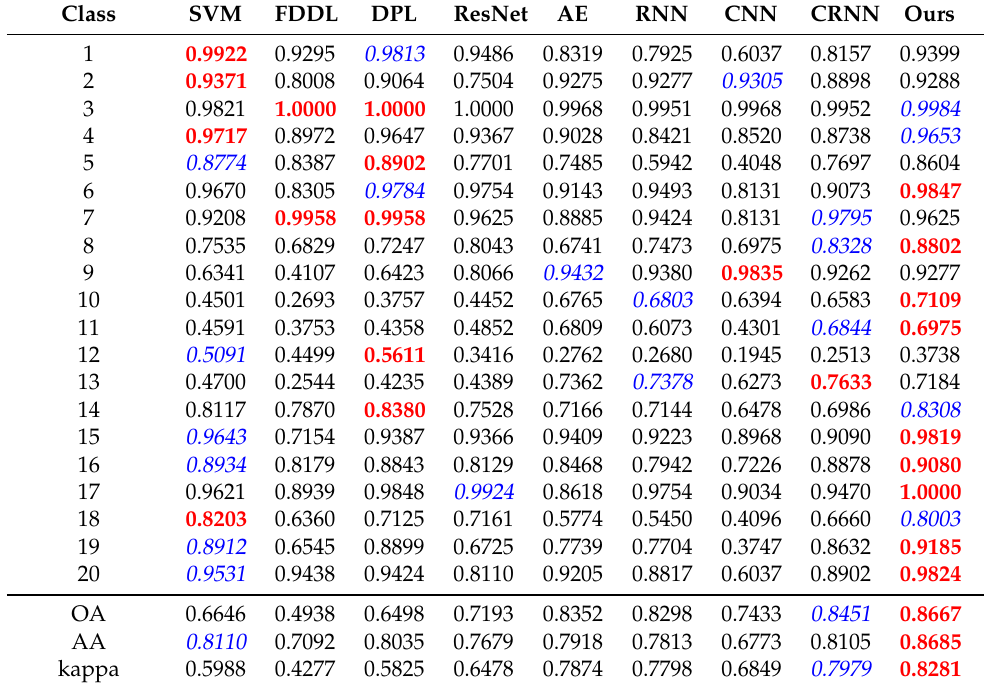
Table 4. Classification Accuracy for Houston 2018 Dataset. The red bold fonts and blue italic fonts indicate the best and the second best